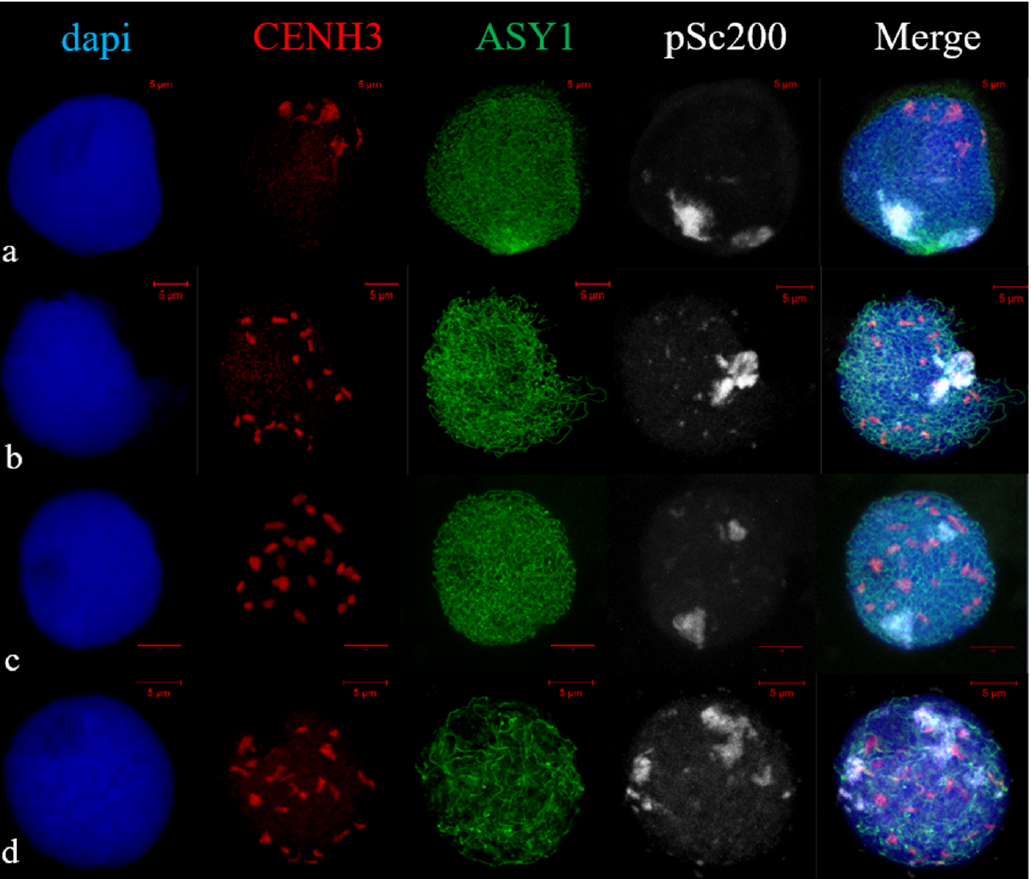
Figure 5. CENH3 and pSc200 behaviour at leptotene-to-pachytene stages, marked ASY1 loading, in 2R(2D) × R hybrids. ( a ) Leptotene. CENH3 indicates centromere clustering, continuous ASY1 signal at restrict area, subtelomeres began to associate in a small area. ( b – d ) Zygotene. ASY1 signals are visible along chromatin axes. Centromeres distributed over nucleus. Subtelomeres are associated in single cluster ( b ), in two clusters ( c ). ( d ) Pachytene. Initiation of ASY1 disassembly, subtelomere distribution. ImmunoFISH. Confocal image, maximum intensity projection. Scale bar = 5 μ m.